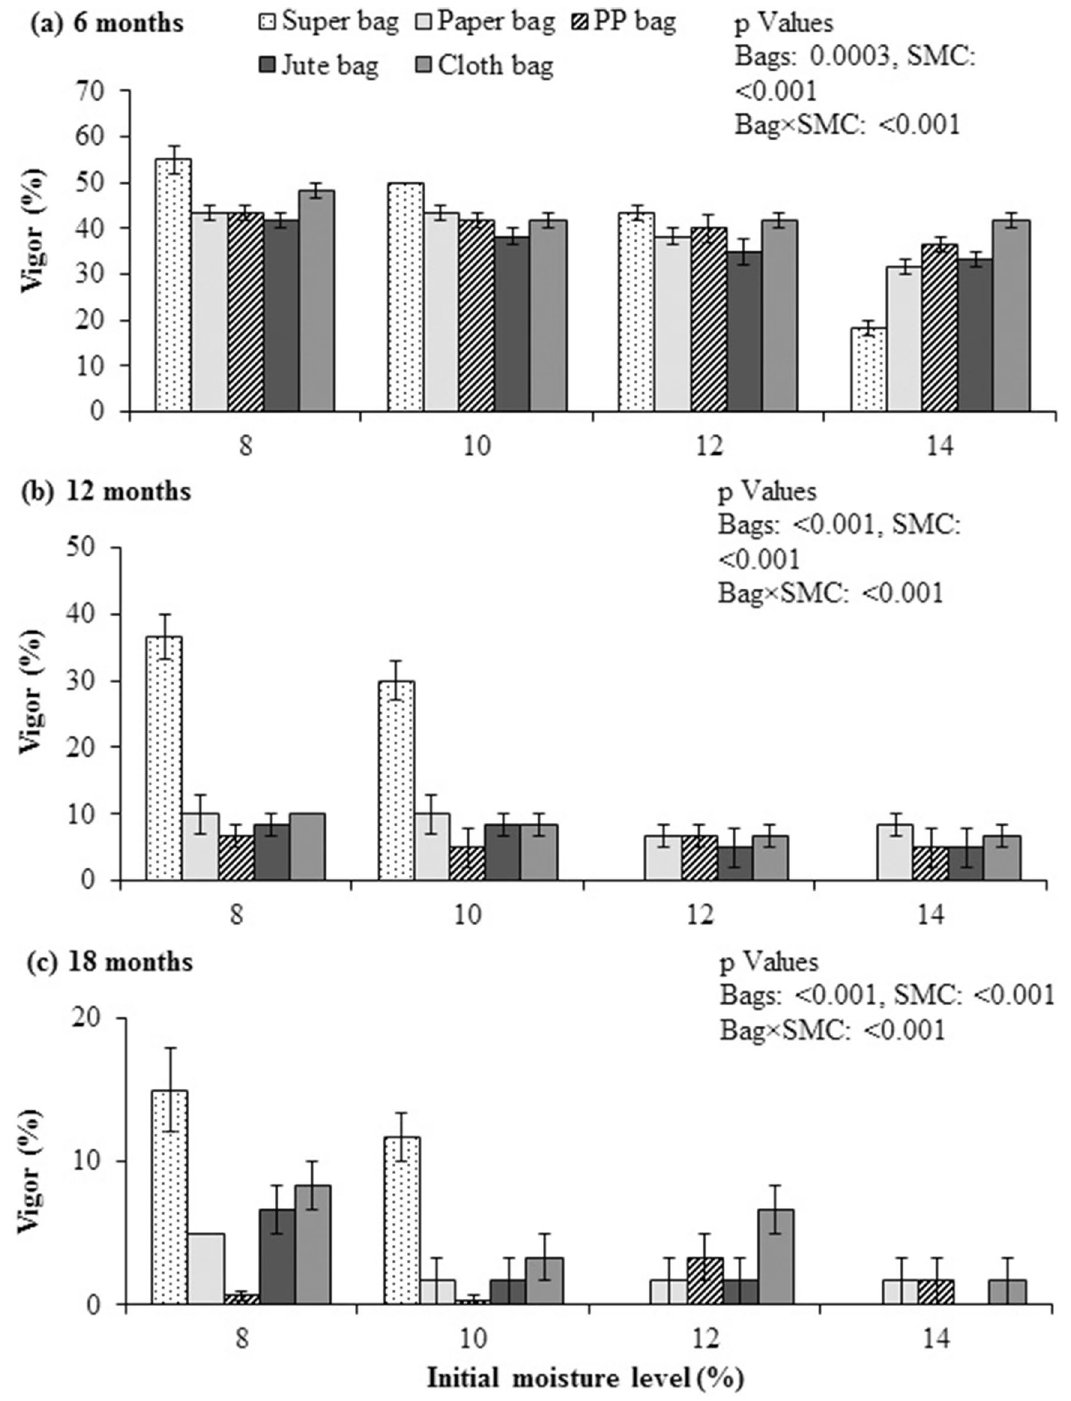
Figure 3. Vigor of quinoa seed following accelerated aging test after 6 ( a ), 12 ( b ) and 18 ( c ) months of storage at various seed moisture levels in different